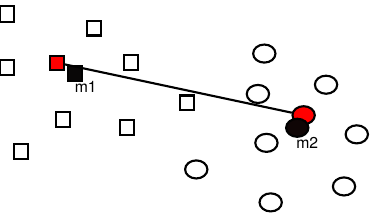
Figure 3. The RSP3-M2 and RSP3E-M2 algorithms divide a subset according to the instances that are closer to the means of the two most common classes in the subset m 1 and m